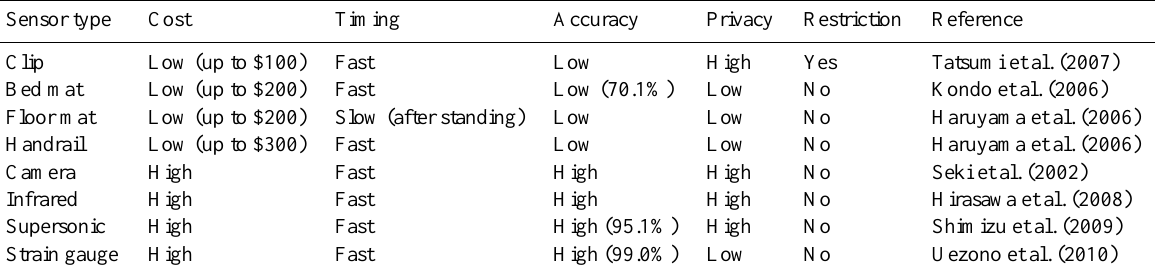
Table 1. Comparison of characteristics of existing bed-leaving